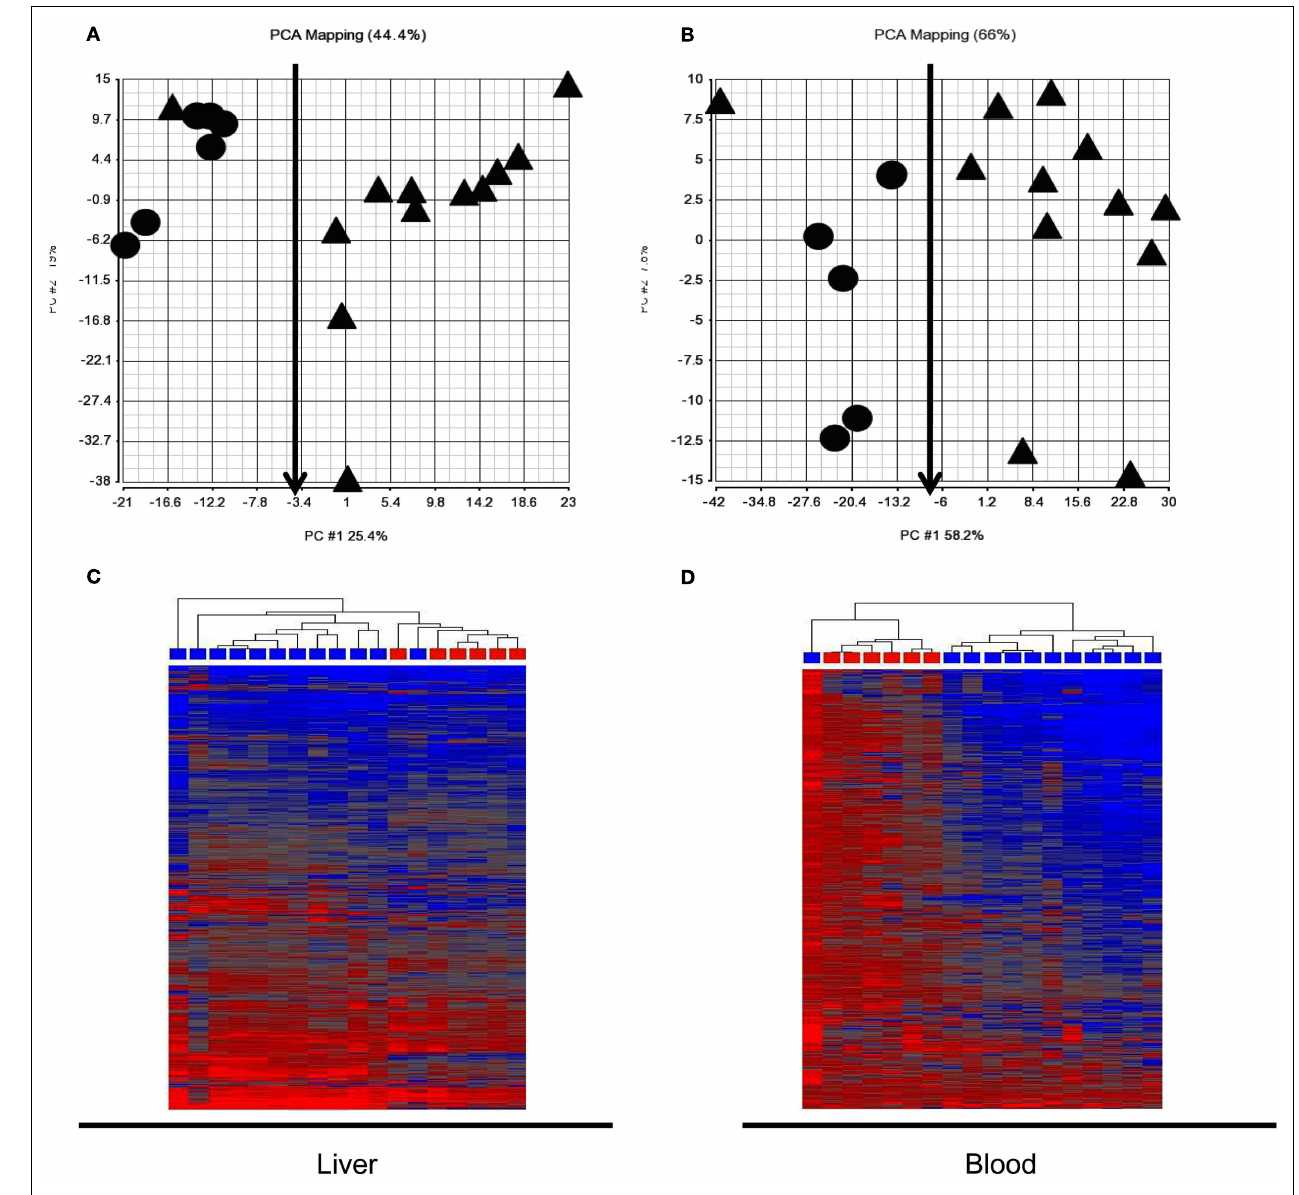
were averaged for each rat so each symbol represents a single animal. (A) Liver PCA result; (B) Blood PCA result; (C) Liver HCA result; (D) . Blood HCA result. For HCA, samples were grouped by Euclidean distance and average linkage. Legends for (A,B) : circle, subtoxic;Triangle, toxic. Legends for (C,D) Red, subtoxic; Blue,